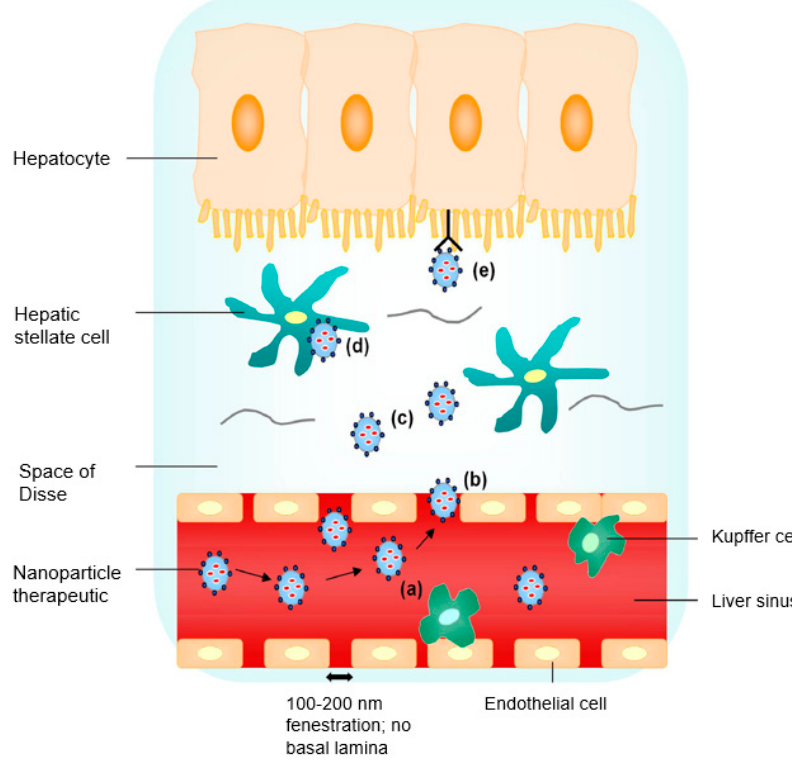
Figure 1. Liver targeting by nanoparticle (NP) therapeutics: ( a ) nanosized particles of less than 200 nm with specific functionalities aid in the evasion of premature Kupffer cell clearance; ( b ) nanosized particles extravasate into the space of Disse through sinusoidal fenestrations in basal lamina absence; ( c ) a high local concentration of NP therapeutics diffusing across the loosely organized extracellular matrix in the space of Disse; ( d ) nonspecific endocytic uptake; and ( e ) receptor-mediated uptake by the hepatocyte (reproduced with permission from [14], © Elsevier B.V. Ltd., 2010). Various drug carriers often fail in delivering drugs to extravascular sites. A strategic plan would be to use low-molecular-weight prodrugs that have the ability to distribute themselves throughout the body, but are cleaved intracellularly to the active form of the drug by an organ-specific enzyme. HepDirect prodrugs are a series of phosphate and phosphonate prodrugs that pursue a cytochrome P450-catalyzed oxidative cleavage reaction inside the hepatocytes. These prodrugs are cyclic 1,3- propanyl esters that contain a ring substrate which presents sensitivity to oxidative cleavage by the cytochrome P450, with specificity to CYP3A4 [15].